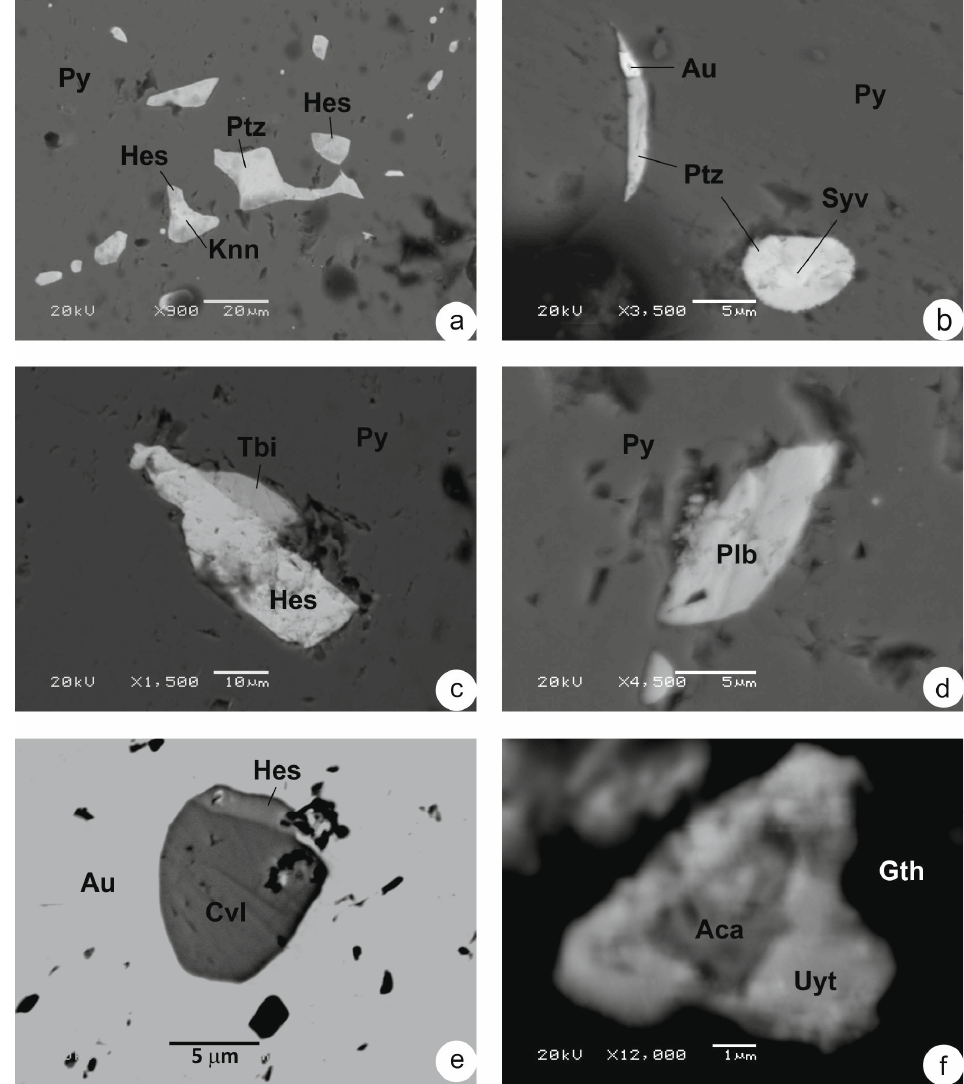
Figure 4. Gold–silver–telluride mineralization of the Spokoininsky ore cluster: ( a , b )—paragenesis of krennerite (Knn), sylvanite (Syv), petzite (Ptz), hessite (Hes), and native gold (Au) in pyrite (Py), ( c )—jointing of hessite (Hes) and tellurobismuthite (Tbi), ( d )—polybasite (Plb) in pyrite (Py), ( e )—cervelleite (Cvl) with hessite (Hes) in supergene gold (Au), ( f )—acanthite (Aca) with a border of uytenbogaardtite (Uyt) in iron hydroxides (Gth). Table 3. Chemical composition of Au, Ag, and Te minerals (in wt.%).